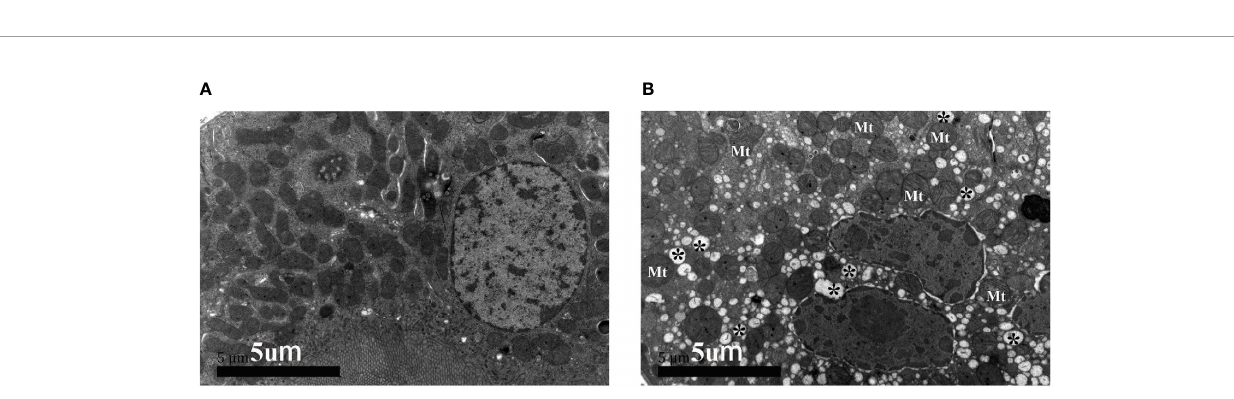
FIGURE 7 | The electron micrographs of control (A) and mouse kidney model of ERS (B) . Swelling of mitochondrion (Mt) and cytoplasmic vacuolar degeneration (*) can be observed in ERS mouse